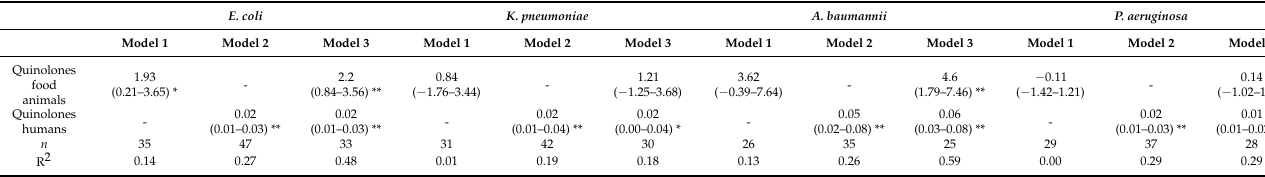
Table 3. Linear regression models testing the country-level association between quinolone consumption in food-producing animals and humans and the prevalence fluoroquinolone resistance in E. coli, K. pneumoniae, A. baumannii and P. aeruginosa spp. [coefficients (95% confidence